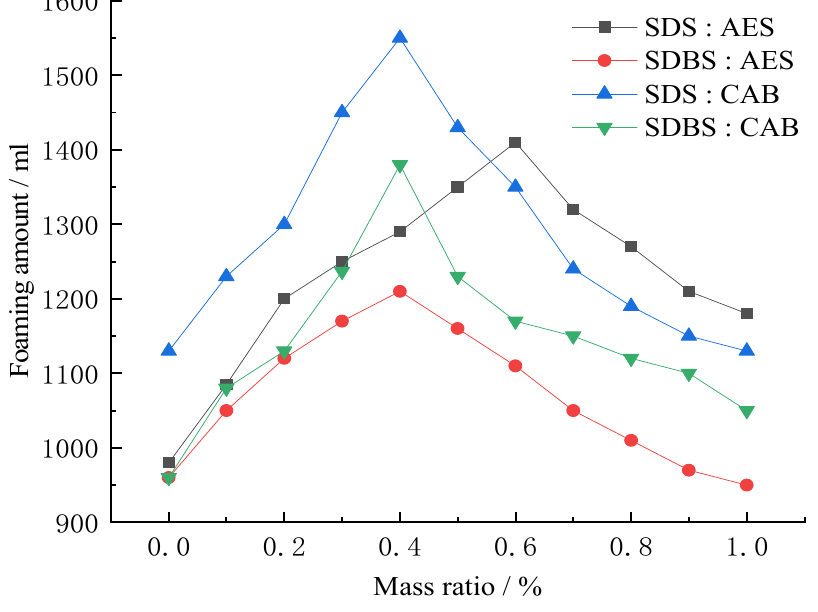
Figure 5. Foaming multiple of pairwise compounding foaming agent.